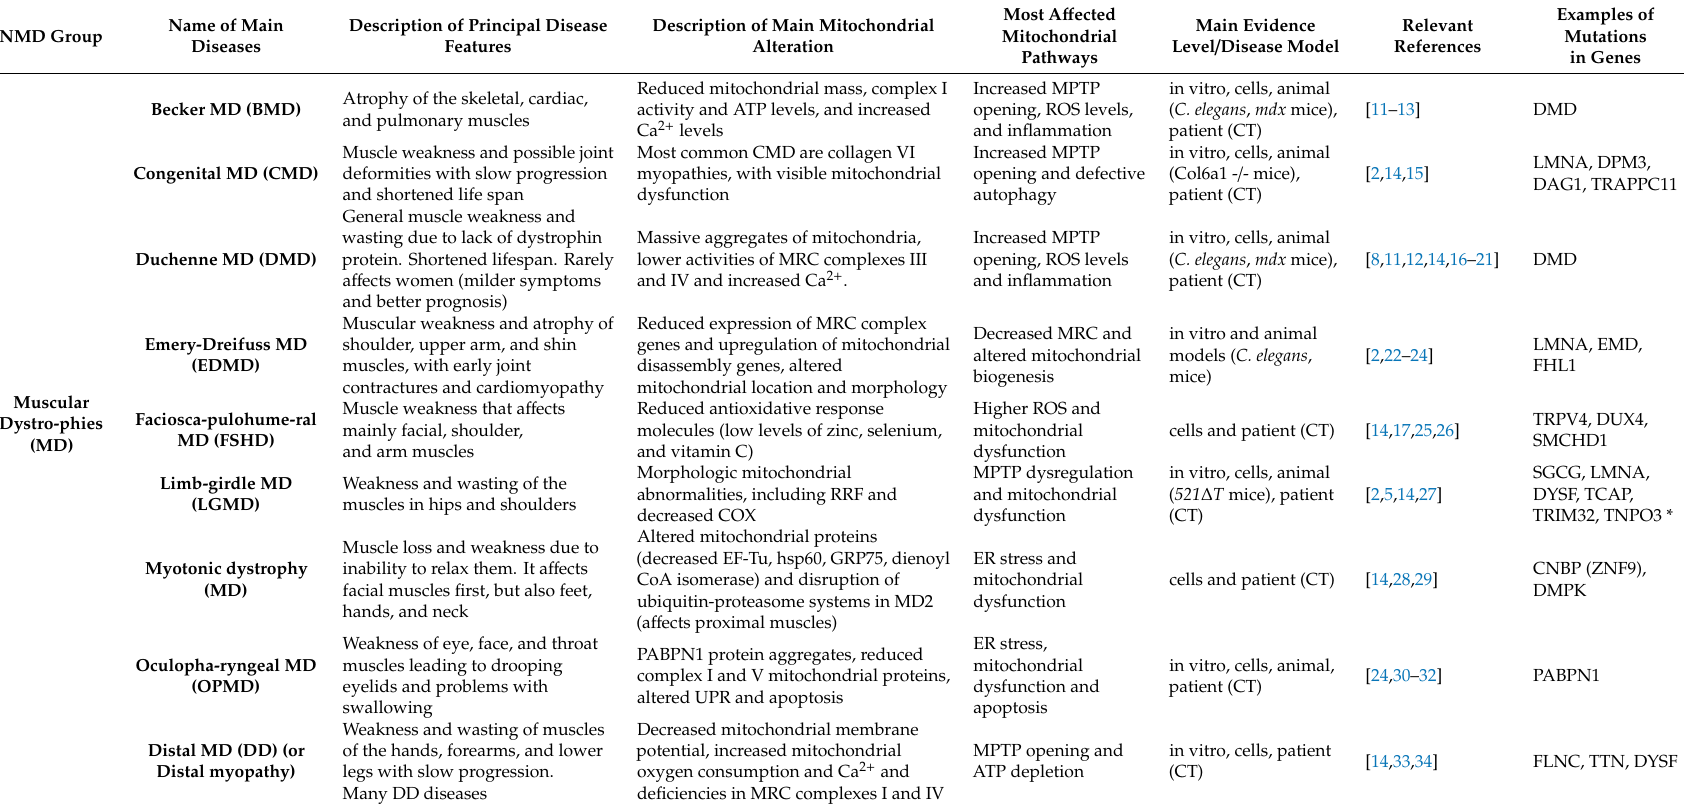
Table 1. Examples of studies reporting altered mitochondrial functions in muscular